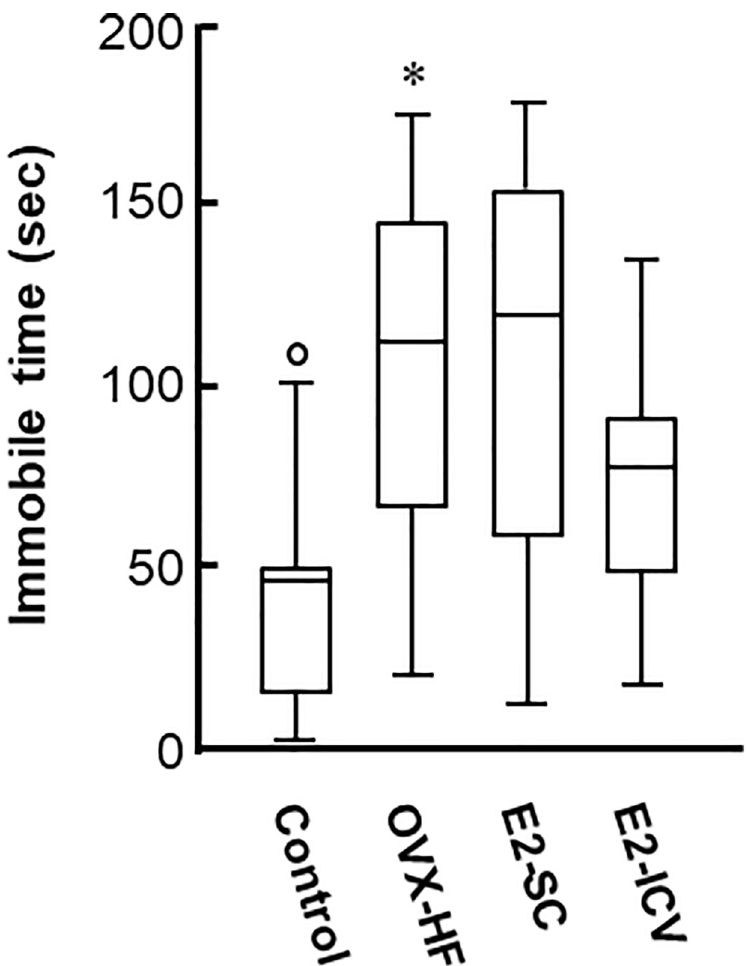
Fig 5. Effects of E2 administration on depression phenotypes in the forced swim test. On day 1, mice were placed in a plastic cylinder filled with water, forced to swim for 15 min, and then returned to the home cage. On day 2, mice were placed into the water again and forced to swim for 6 min. The duration of immobility was recorded during the last 5 min of the session as an index of depression-like behavior. Results are shown as Turkey style box plots with data falling outside the lower and upper quartiles plotted as circles. Values are the mean ± SE (control, n = 8; OVX-HF, n = 9; E2-SC, n = 11; E2-ICV, n = 8). P values were determined by the two-tailed Kruskal Wallis H-test with the Mann- Whitney U-test. �� P < 0.01, � P < 0.05 vs. the control group; †† p < 0.01 vs. the OVX-HF group.